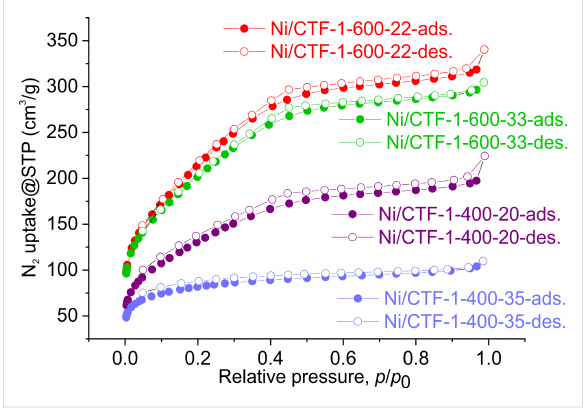
Figure 4: Nitrogen adsorption and desorption isotherms (at 77 K) of Ni/CTF-1 composites.